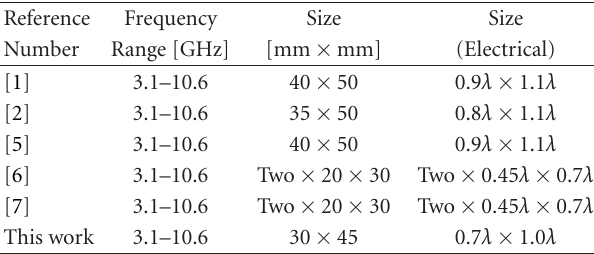
Table 3: Frequency and size comparison between 3dB couplers and power